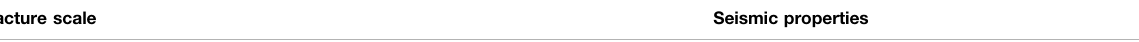
TABLE 1 | Multi-scale natural fractures and their prediction methods. Fracture scale Seismic